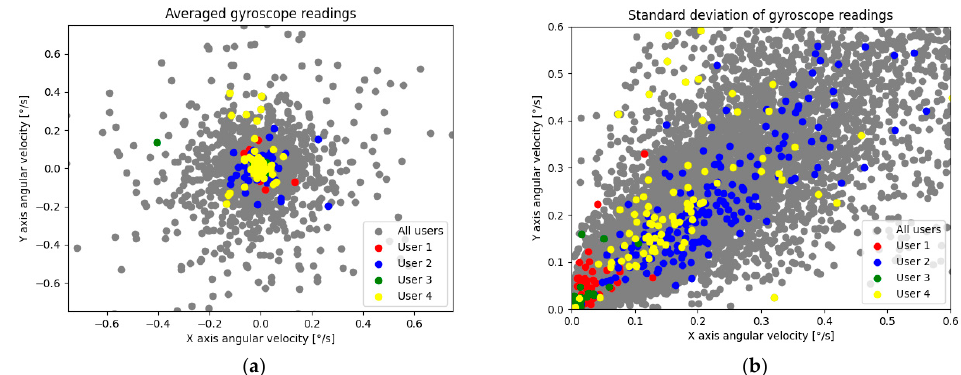
Figure 6. Average ( a ) and standard deviation ( b ) of gyroscopes’ x and y axes (all users).